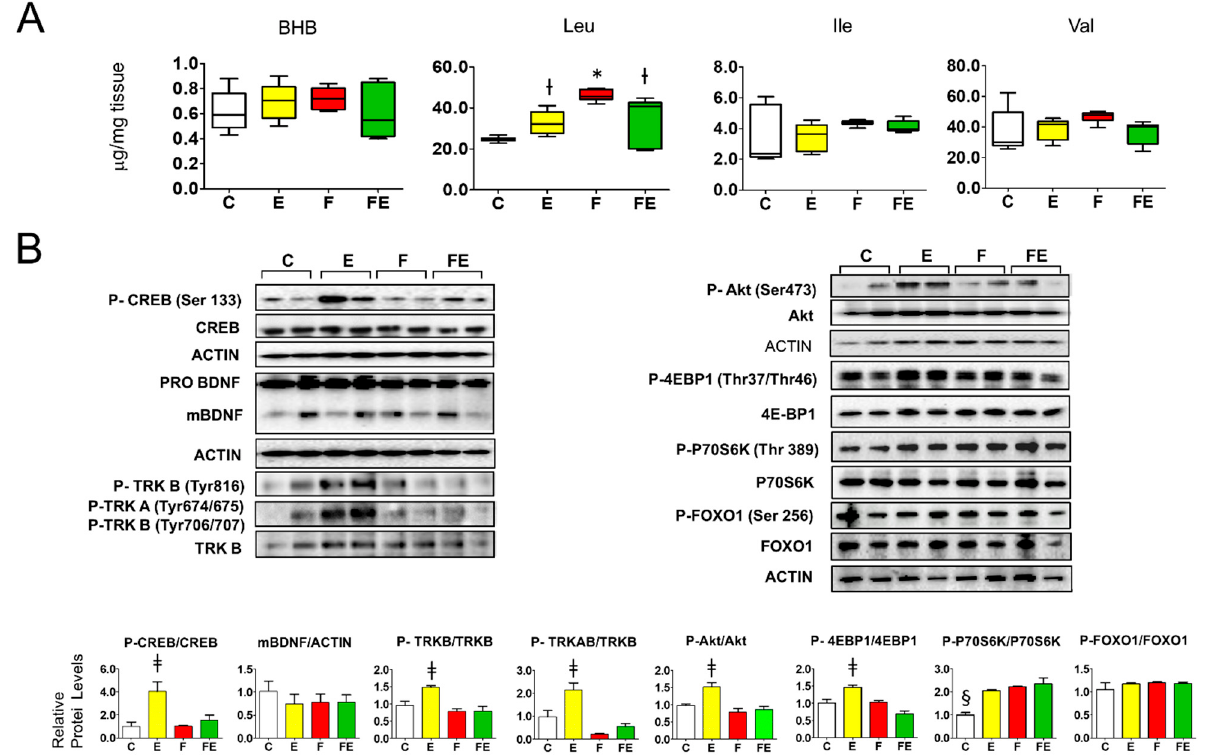
Figure 4. Association of tissue beta hydroxy butyrate and branched-chain amino acids with BDNF- Akt-mTOR-FOXO1 signaling in the prefrontal cortex of fasted rats undergoing mild endurance exercise. ( A ): Mass Spectrometry analysis of prefrontal cortex levels of BHB, Leu, Ile, and Val; ( B ): Western immunoblot analysis of prefrontal cortex proteins involved in BDNF-mTOR signaling, with quantified data shown below. ( A , B ): Analysis was carried out comparing control rats with rats subjected to exercise, fasting, or fasting with exercise. ( N = 4, n = 3). One way ANOVA was carried out followed by a Newman Keuls post-hoc test. * p < 0.05 vs. C, † p < 0.05 vs. C and F, ‡ p < 0.05 vs. C, F and FE. § p < 0.05 vs. E, F and FE. Abbreviations: N: biological replications, n: technical replica- tions. Data are shown as means ± SEM.